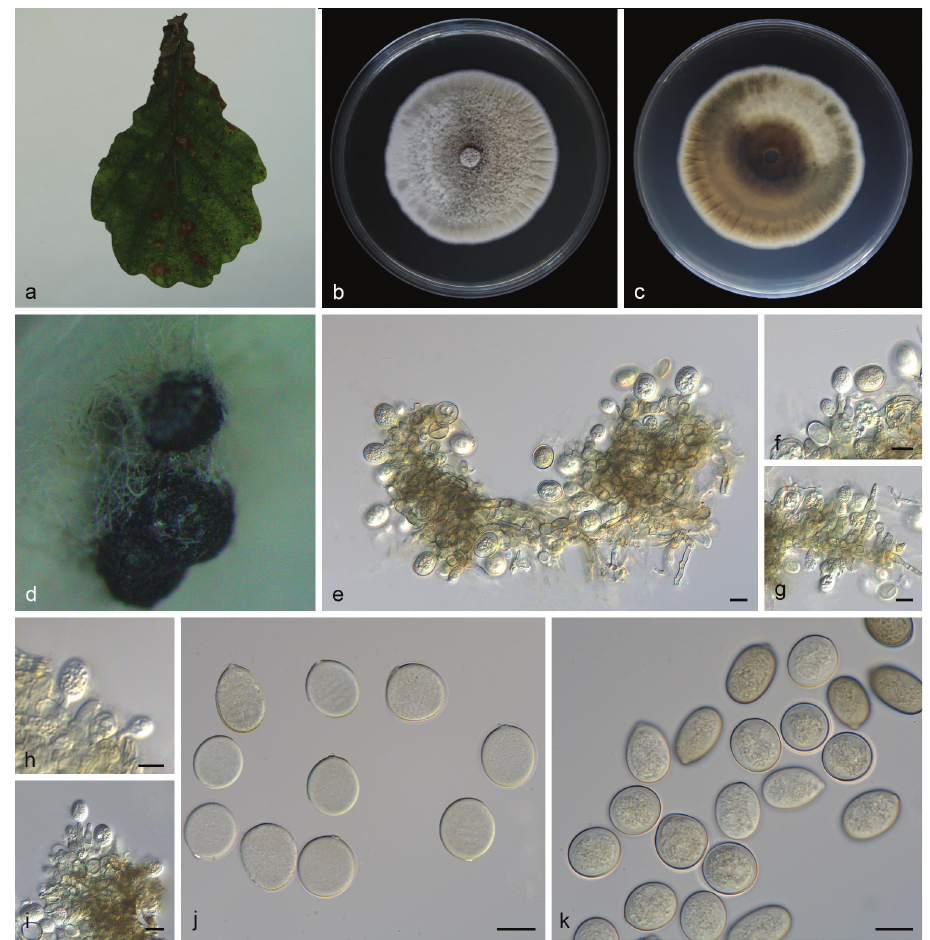
Figure 4. Tubakia lushanensis (SAUCC 1923). a diseased leaf of Quercus palustris; b surface of colony after 15 days on MEA; c reverse of colony after 15 days on MEA; d conidiomata; e–i conidiogenous cells with conidia; j–k conidia. Scale bars: 10 μm ( e–k